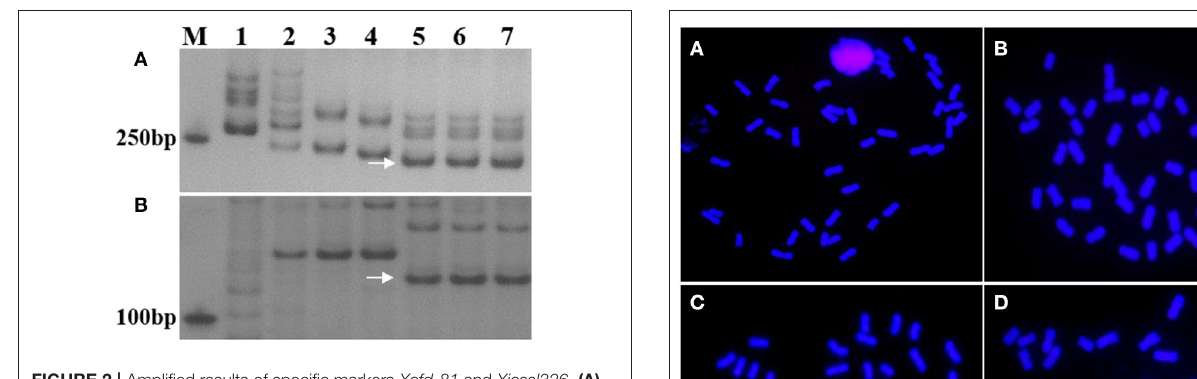
FIGURE 2 | Amplified results of specific markers Xcfd-81 and Xicssl326 . (A) Xcfd-81 . (B) Xicssl326 . Lanes: M, DL2000 marker; 1–7 refer to Th. ponticum , SNTE20, YN15, SN224, JM22, SN0293-2, and SN0293-7, respectively. Arrows indicate specific bands.